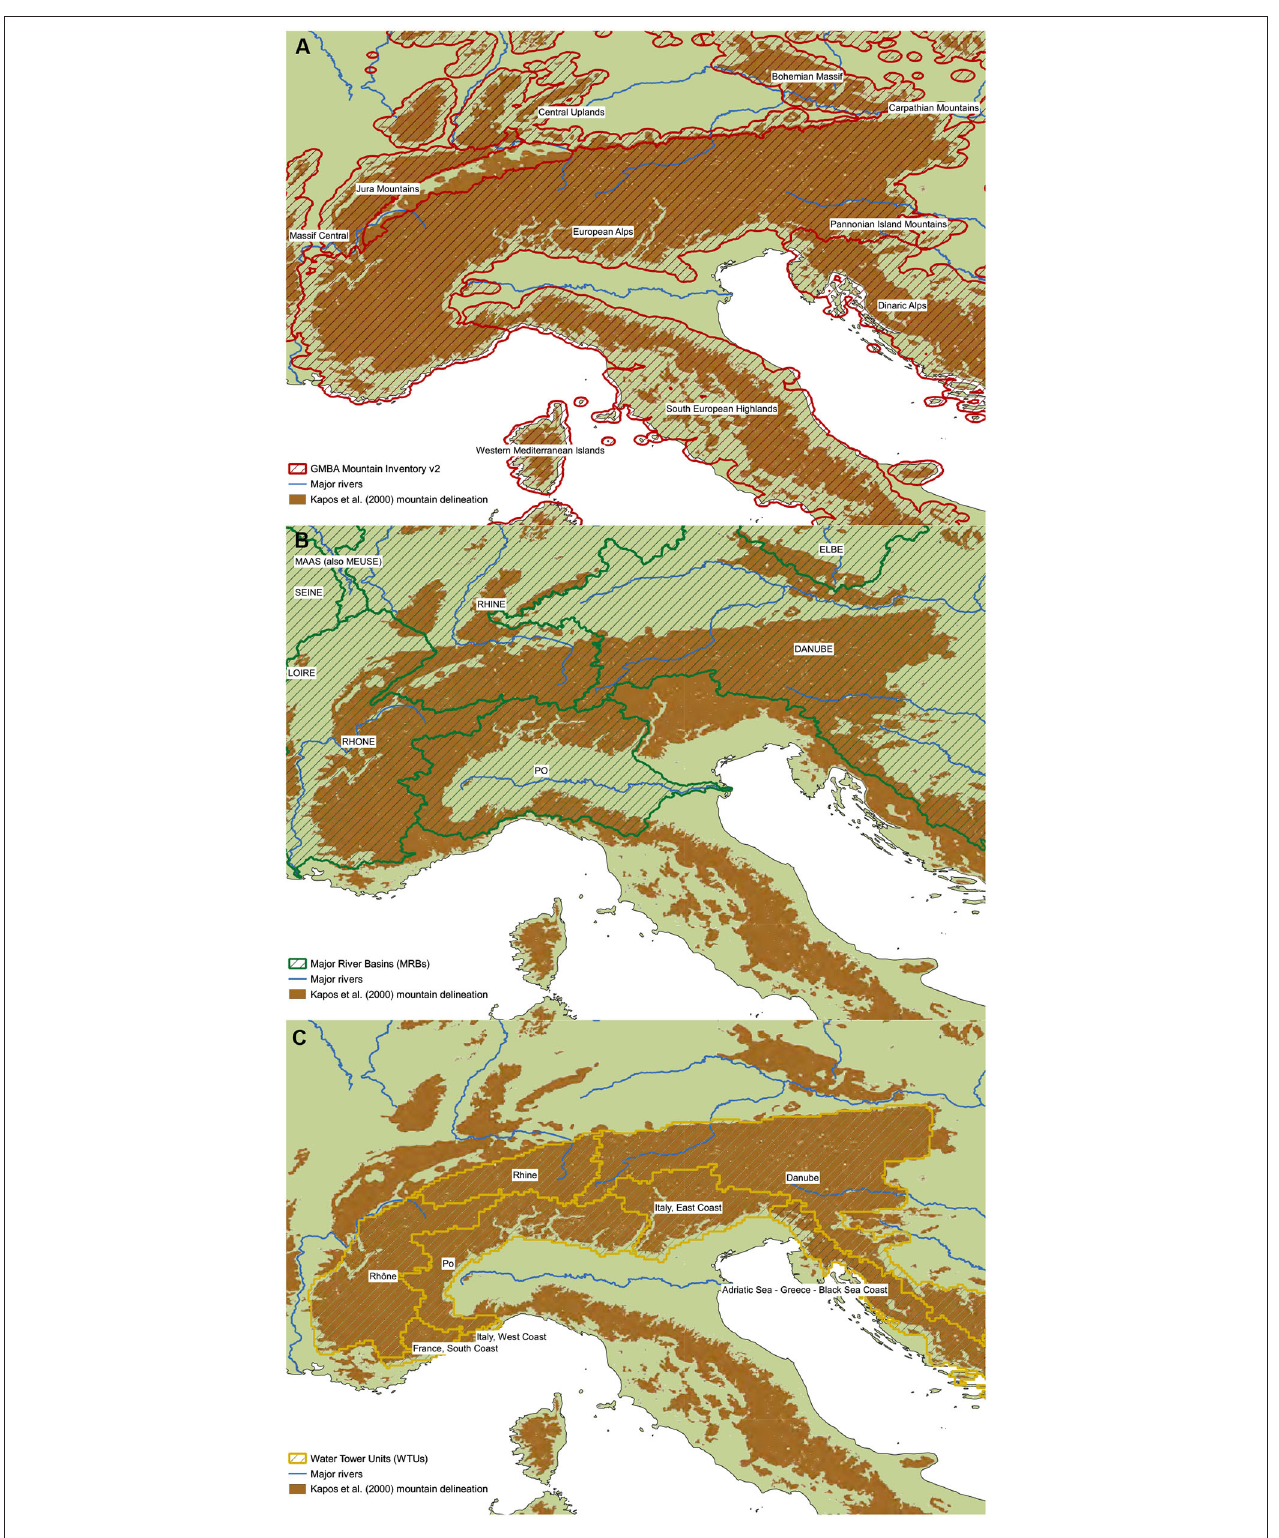
FIGURE 1 | Illustration of the spatial polygon datasets used in this study for aggregation and reporting for a region centered on the European Alps; the GMBA Mountain Inventory v2 (Snethlage et al., 2022a) (A) , major river basins (MRBs) (GRDC, 2020) (B) , and Water Tower Units (WTUs) (Immerzeel et al., 2020a,b) (C) .